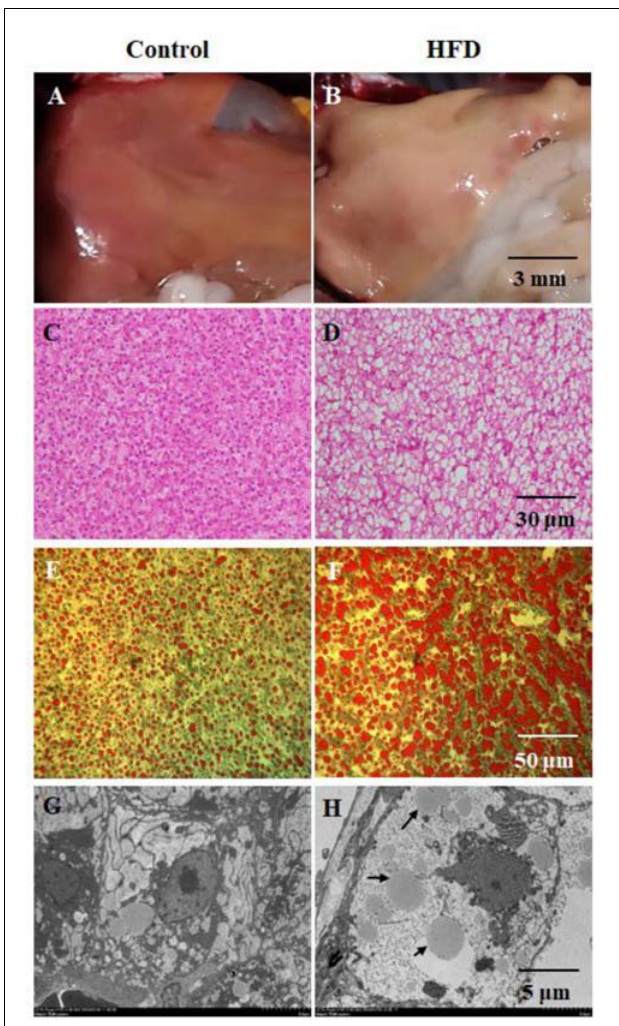
FIGURE 1 | Gross phenotype and histopathology in tilapia fed on control diet and HFD at 90 day. (A,B) gross appearance of liver; (C,D) hematoxylin and eosin (H&E)-stained section of liver; (E,F) oil red O-stained section of liver; (G,H) electron microscopic image of liver, the black arrows indicates lipid